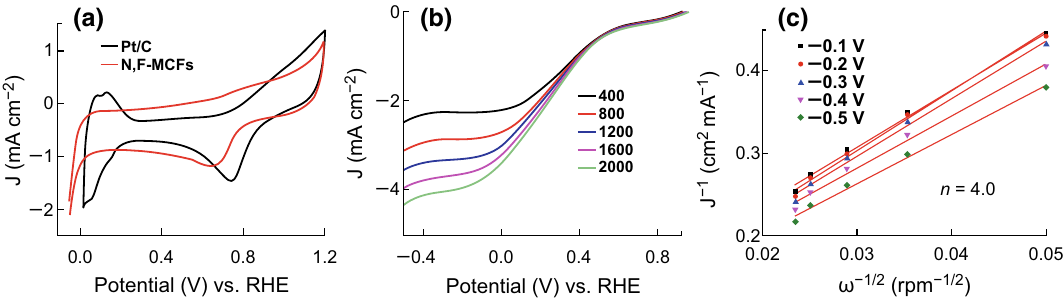
Fig. 5 a CV curves of N, F-MCFs-A and Pt/C 20% in O 2 -saturated 0.5 M H 2 SO 4 with a scan rate of 10 mV s −1 . b LSV curves and c K – L plots of N, F-MCFs-A in O 2 -saturated 0.5 M H 2 SO 4 with a scan rate of 10 mV s −1